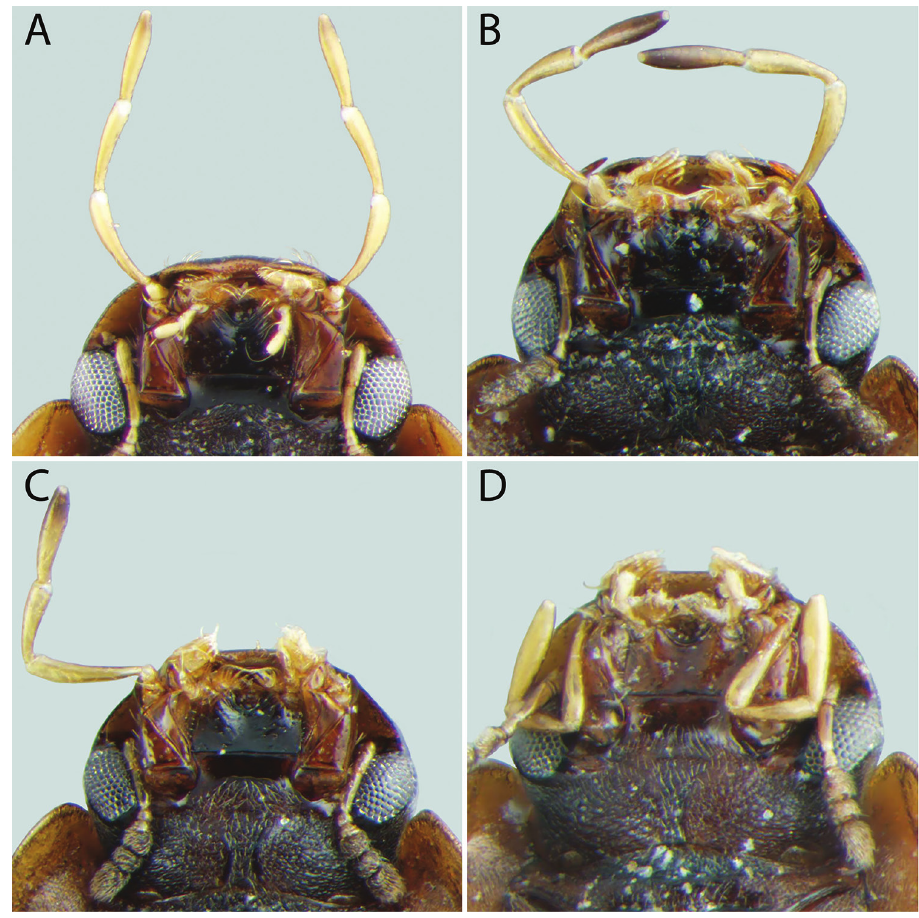
Figure 8. Ventral view of heads of Tobochares spp. A T. kusad sp. n. B T. striatus C T. sulcatus D T. cana- liculatus sp.